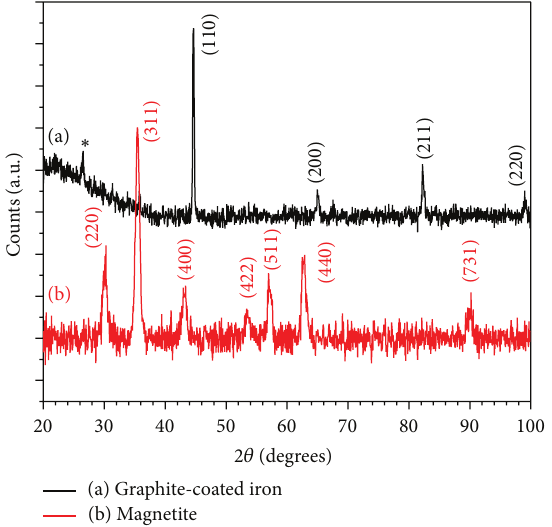
Figure 2: X-ray diffraction of graphite-encapsulated iron nanopar- ticles (a) and bare magnetite (b); the peak marked by ∗ corresponds to the plane (002) of graphite.